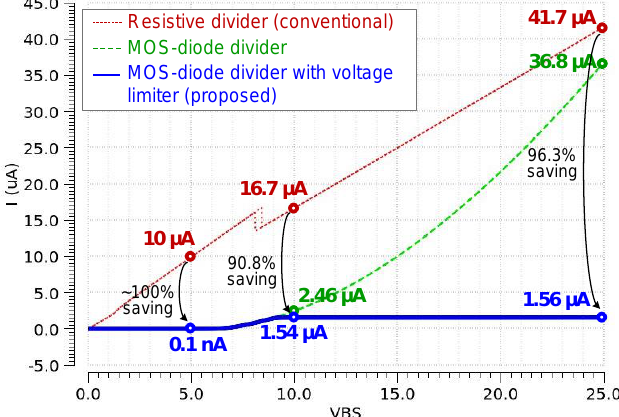
Figure 5. Current consumption of different types of supply-voltage sensors.